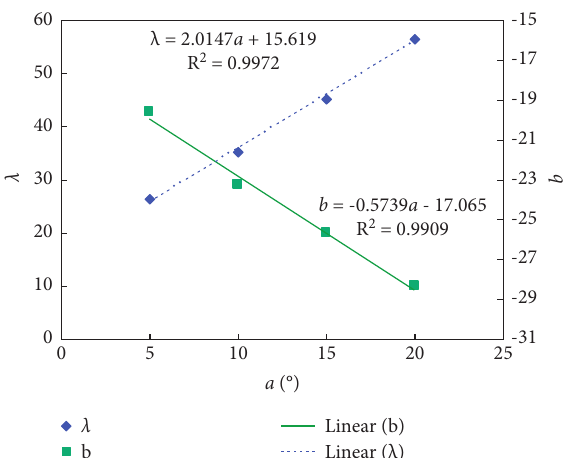
Figure 4: A linear relationship between the parameters λ and b of the proposed model and the rake angle of the bit